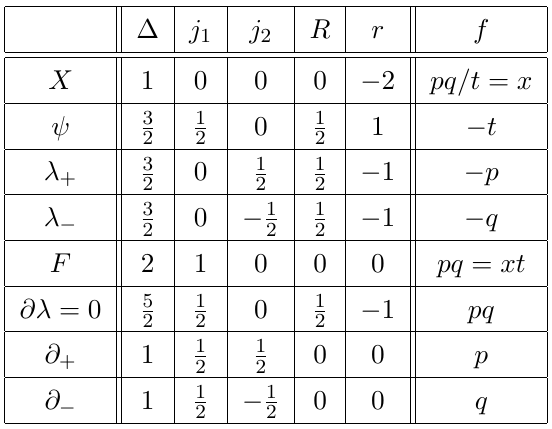
Table 3 . Letters and their charges in the N = 2 vectormultiplet